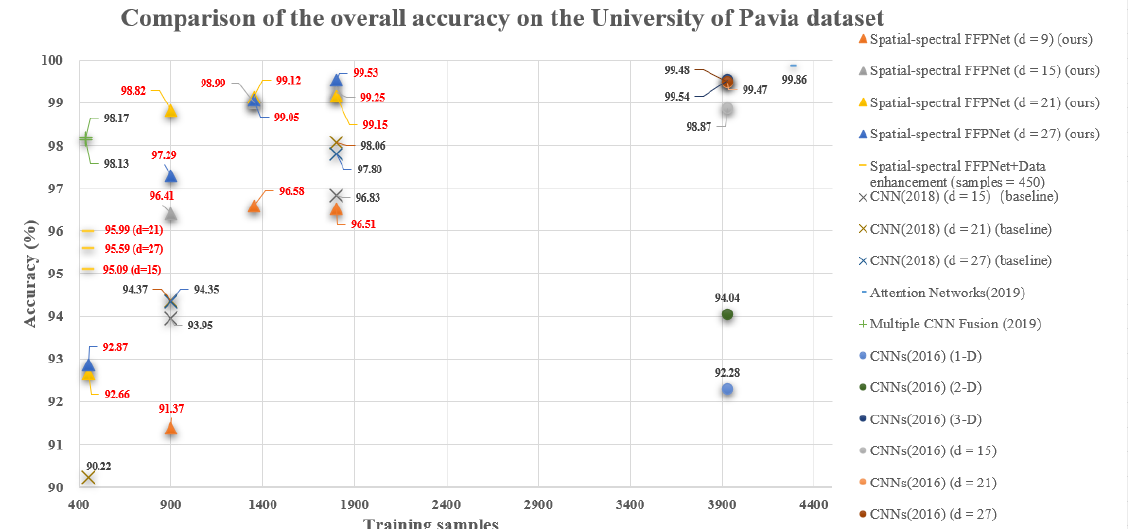
Figure 16. Comparison of the OA obtained by different CNN models for the UP dataset. The abscissa represents the total number of training samples (400–4400), and the ordinate represents the OA (%) of the CNN models. The figure mainly compares the accuracy of different models (existing CNN methods and the proposed spatial-spectral FFPNet) under different training samples. In the legend, different shapes represent different methods for hyperspectral classification. In the same shape, different colors indicate different configurations of the same method. The OA results obtained by our proposed model are presented in red and those obtained by the existing CNNs [40,41], attention networks [45], and multiple CNN fusion [42] are presented in